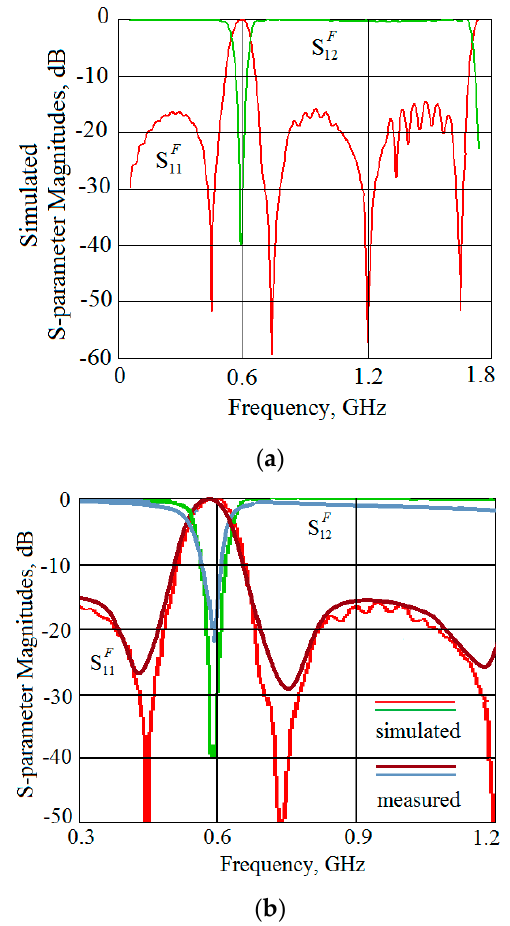
Figure 8. Measured and simulated S-parameters of the proposed bandstop filter: ( a ) the simulation-derived results in the frequency range 0.1–1.8 GHz, ( b ) these results, as well as the experimental ones, are through the whole frequency band of the DS 7710A Network Analyser